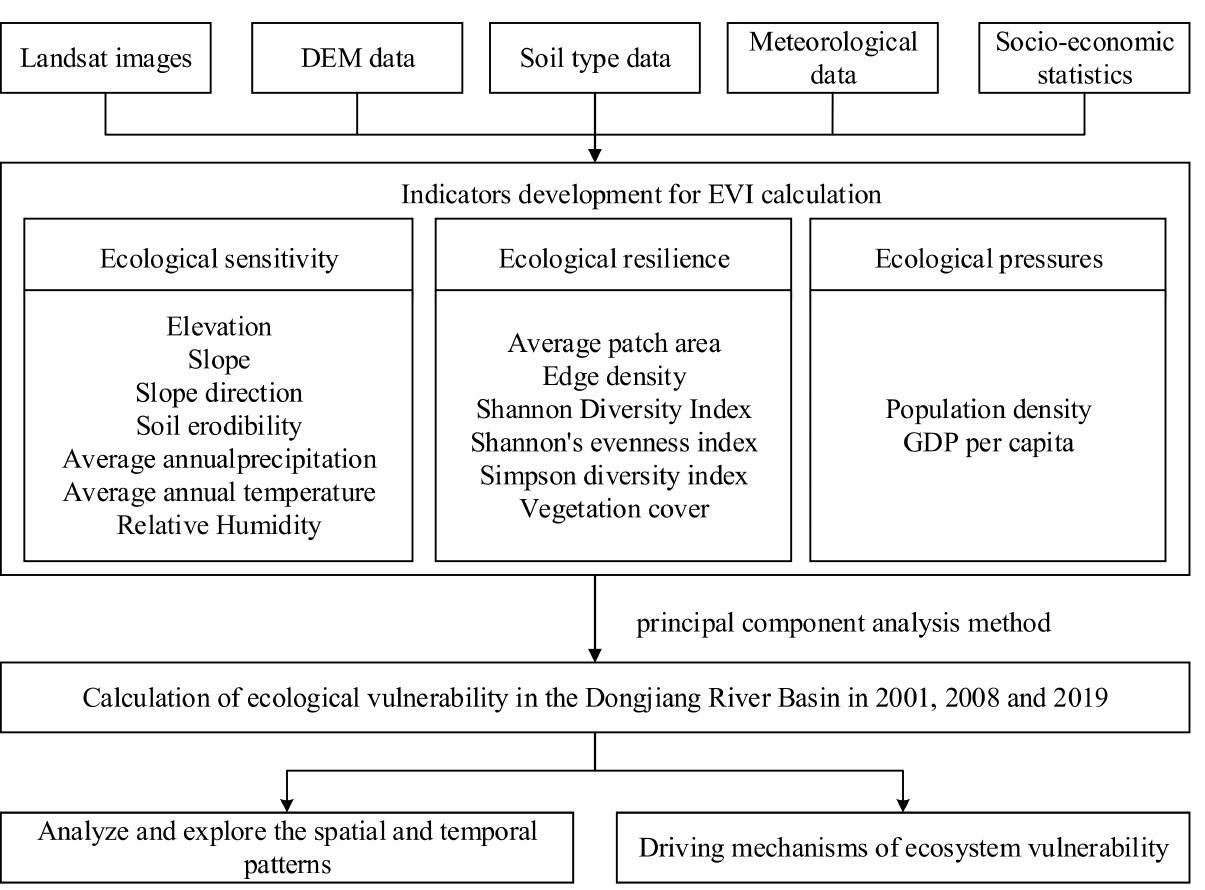
Figure 1. Stepwise procedure for spatio-temporal EVI